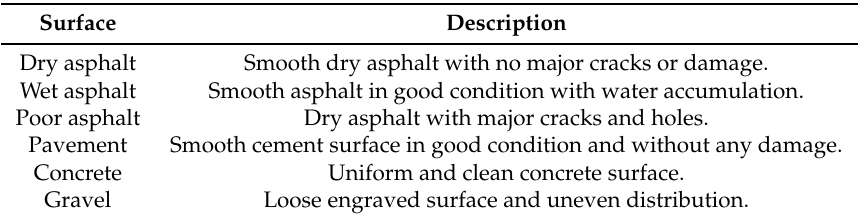
Table 1. Description of different tested surfaces.